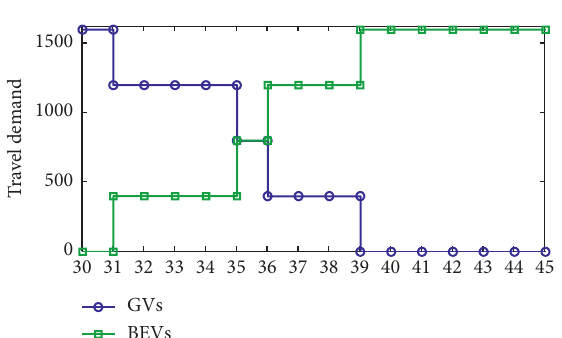
Figure 3: Changing distance limit of BEVs of all O-D pairs in Nguyen–Dupuis’